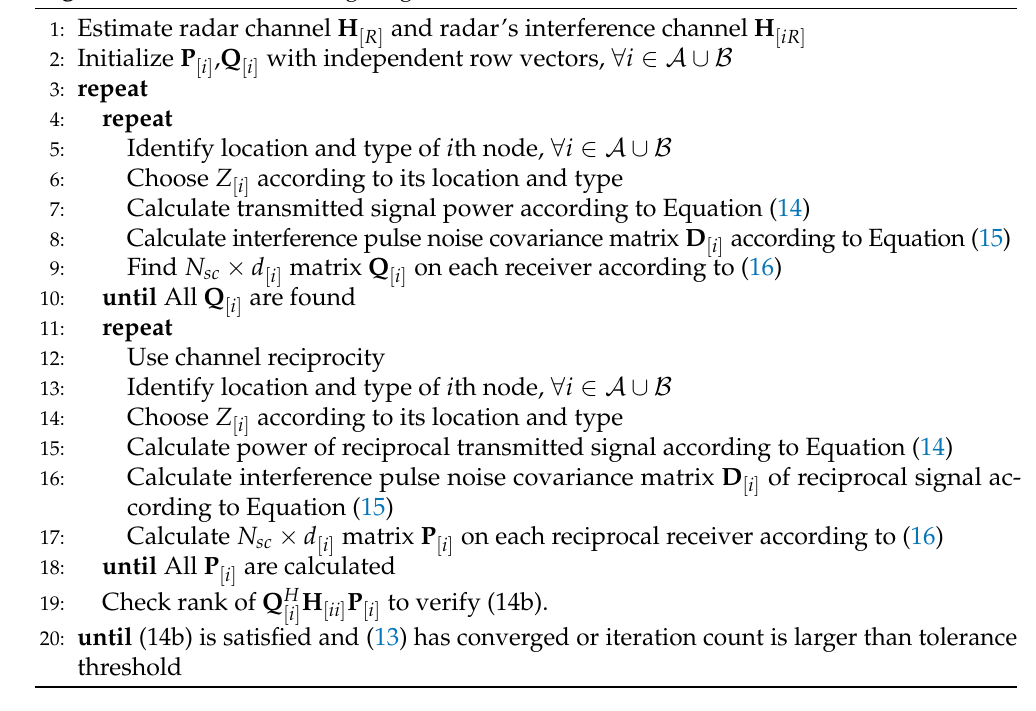
Algorithm 1 Max-SINR design